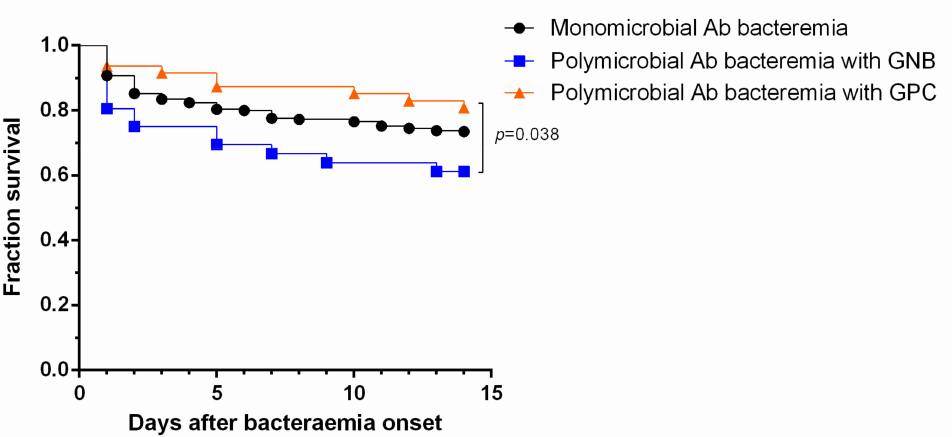
Figure 1. Kaplan–Meier plot showing the survival rates of patients with acquired monomicrobial Acinetobacter baumannii (Ab) bacteremia, polymicrobial Ab bacteremia with concomitant Gram-negative bacilli (GNB), and polymicrobial Ab bacteremia with concomitant Gram-positive cocci (GPC) (polymicrobial Ab bacteremia with concomitant GNB versus monomicrobial Ab bacteremia, p = 0.098 by log-rank test; polymicrobial Ab bacteremia with concomitant GPC versus monomicrobial Ab bacteremia, p = 0.265 by log-rank